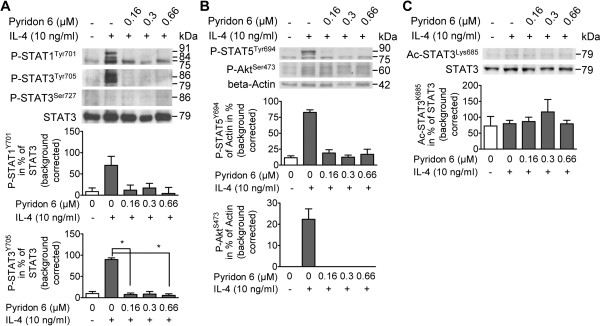
IL-4-activated JAK signaling results in the phosphorylation of STATs and Akt. Lymphocytes were preincubated for 30 min prior to the addition of IL-4 with/without pyridon 6. After 2 h IL-4 stimulation, activation of JAK downstream signaling molecules (others than STAT6) was investigated in cell lysates using Western Blotting followed by densitometry. Representative immunoblots are shown; the same blot was probed sequentially with different antibodies. Densitometry results are given as mean % expression of loading control ± SEM in the bar graphs; statistical analysis was performed using the Friedman and Dunn’s test; *P < 0.05. A) Phosphorylation of STAT1 (Tyrosine 701, 84/91 kDa) and STAT3 (Tyrosine 705, 79/86 kD and Serine 727, 86 kDa) and inhibition by pyridon 6; loading was controlled by staining for non-phosphorylated STAT3 (79/86 kDa). The bar graphs show the mean expression of phosphorylated STAT1 (n = 3 independent experiments), Tyrosine-phosphorylated STAT3 (n = 6 independent experiments, and Serine-phosphorylated STAT3 (n = 3 independent experiments) in % of STAT3, respectively. B) Phosphorylation of STAT5 (Tyrosine 694, 90 kDa) and of Akt (Serine 473, 60 kDa) and inhibition by pyridon 6; loading was controlled by staining for beta-actin (42 kDa). The bar graphs show the mean expression of phospho-STAT5 (n = 3 independent experiments) and phospho-Akt (n = 3 independent experiments) in % of beta-actin, respectively. C) Acetylation of STAT3 (Lysine 685, 79/86 kDa) and inhibition by pyridon 6; loading was controlled by staining for STAT3 (79/86 kDa). The bar graph shows the expression of Acetyl-STAT3 (n = 3 independent experiments) in % of STAT3. Ac; acetylated; Lys; Lysine; Ser, Serine; Tyr, Tyrosine.